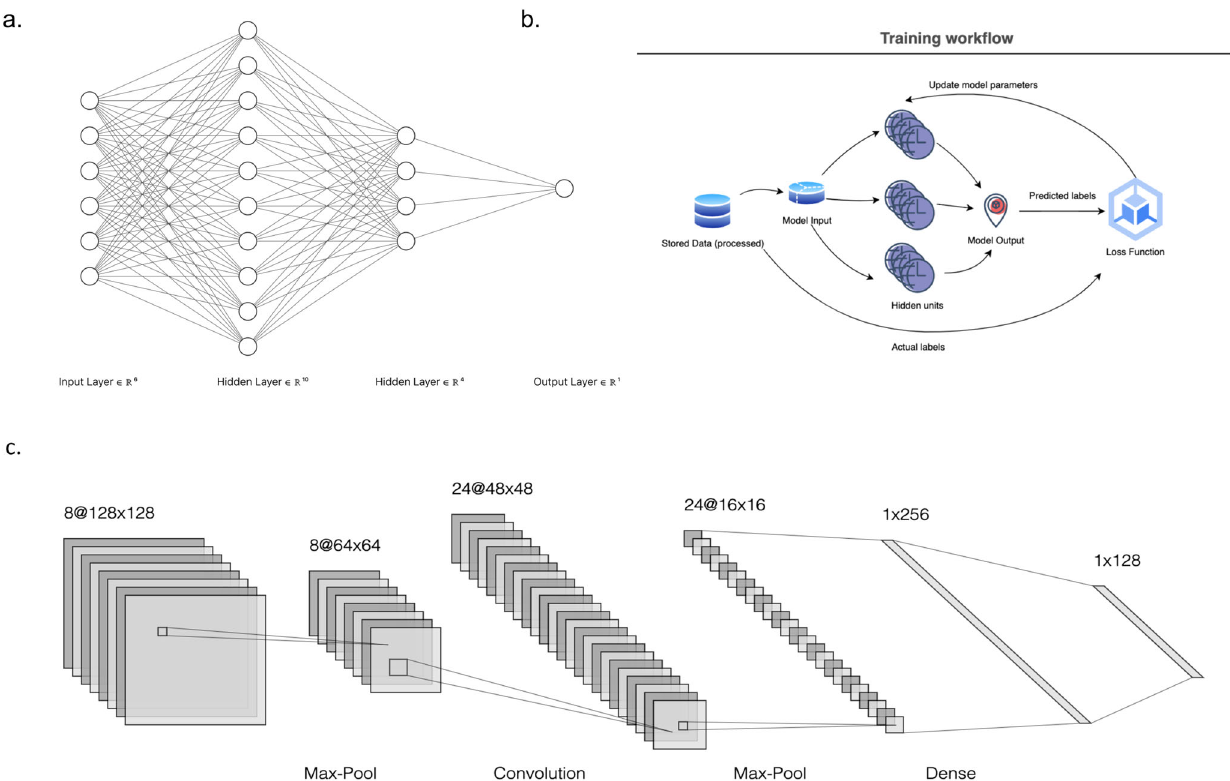
Fig. 1 Example neural network architectures. a Basic neural network demonstrating input nodes with dimensionality of 8, two hidden layers that involve dimension expansion and subsequent reduction with a fi nal output node. Each input node is connected to each of the hidden nodes (a fully connected network), with lines connecting nodes representing weights applied to a source to reach a destination. The above representation can also be visualized as a weight matrix, translating from the dimensionality of the input nodes to the dimensionality of the output nodes. b A pictorial the training process – inputs are fed to a DL network, predictions are made and compared to ground truth labels and parameters are updated in a loop. c A convolutional network architecture demonstrating the typical backbone of pooling layers followed by convolutional layers. Note that convolutions increase the number of fi lters while reducing dimensionality in the x/y dimensions